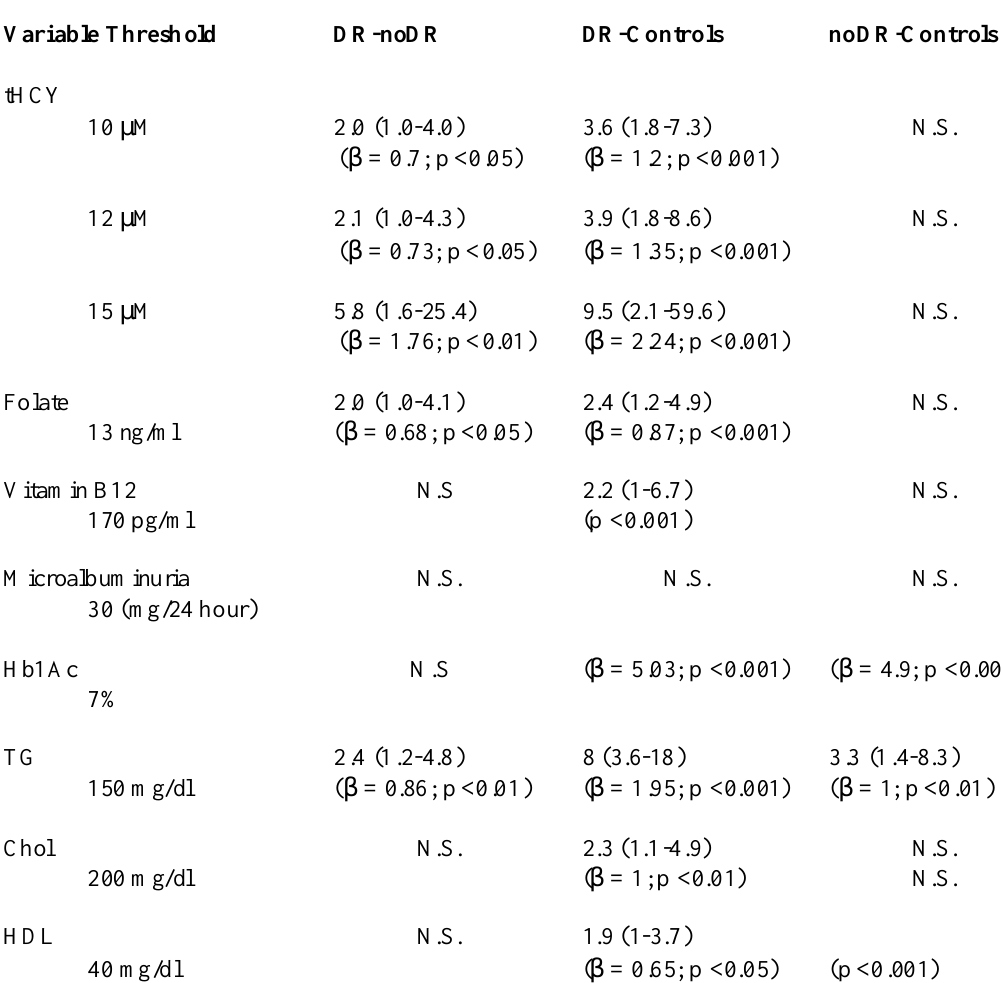
Table 4.: Adjusted odds ratio and 95% confidence interval for associations between key risk factors of diabetes patients with and without retinopathy (DR) and controls according to a logistic regression model. tHCY = total homocysteine, TG = triglycerides, Chol =